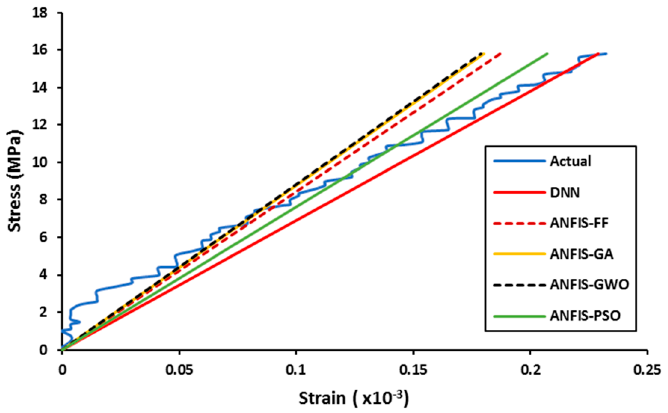
Figure 7. Stress-Strain behavior of rock sample ( 𝑦 direction).